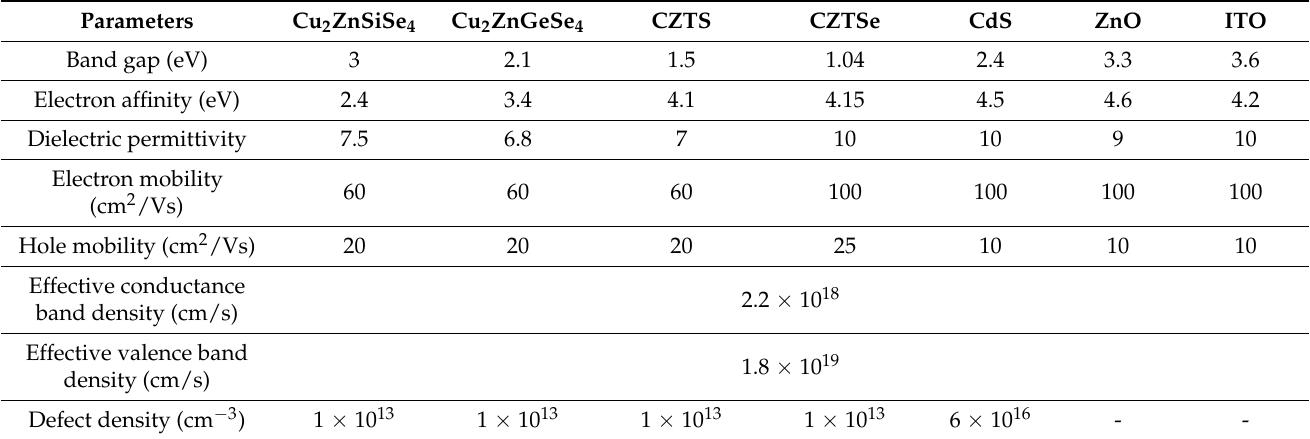
Table 1. Standard material parameters used in the solar cell design shown in Figure